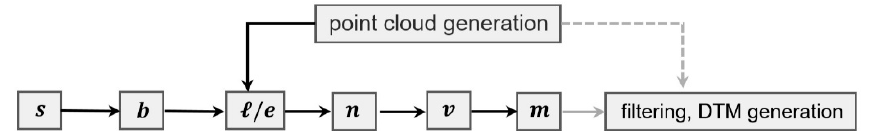
Figure 3. Transformation between intermediate coordinate systems (right-handed) in generating point cloud coordinates by airborne laser scanning data: s —sensor frame, defined by principle axes of laser scanner, b —body frame, realized by the triad of accelerometers in INS, e —earth-centered earth-fixed (ECEF) frame, i.e., ITRF, ℓ —Local geodetic coordinate system, n —national coordinate datum, v —national vertical datum, m —map projection grid coordinate system [7].